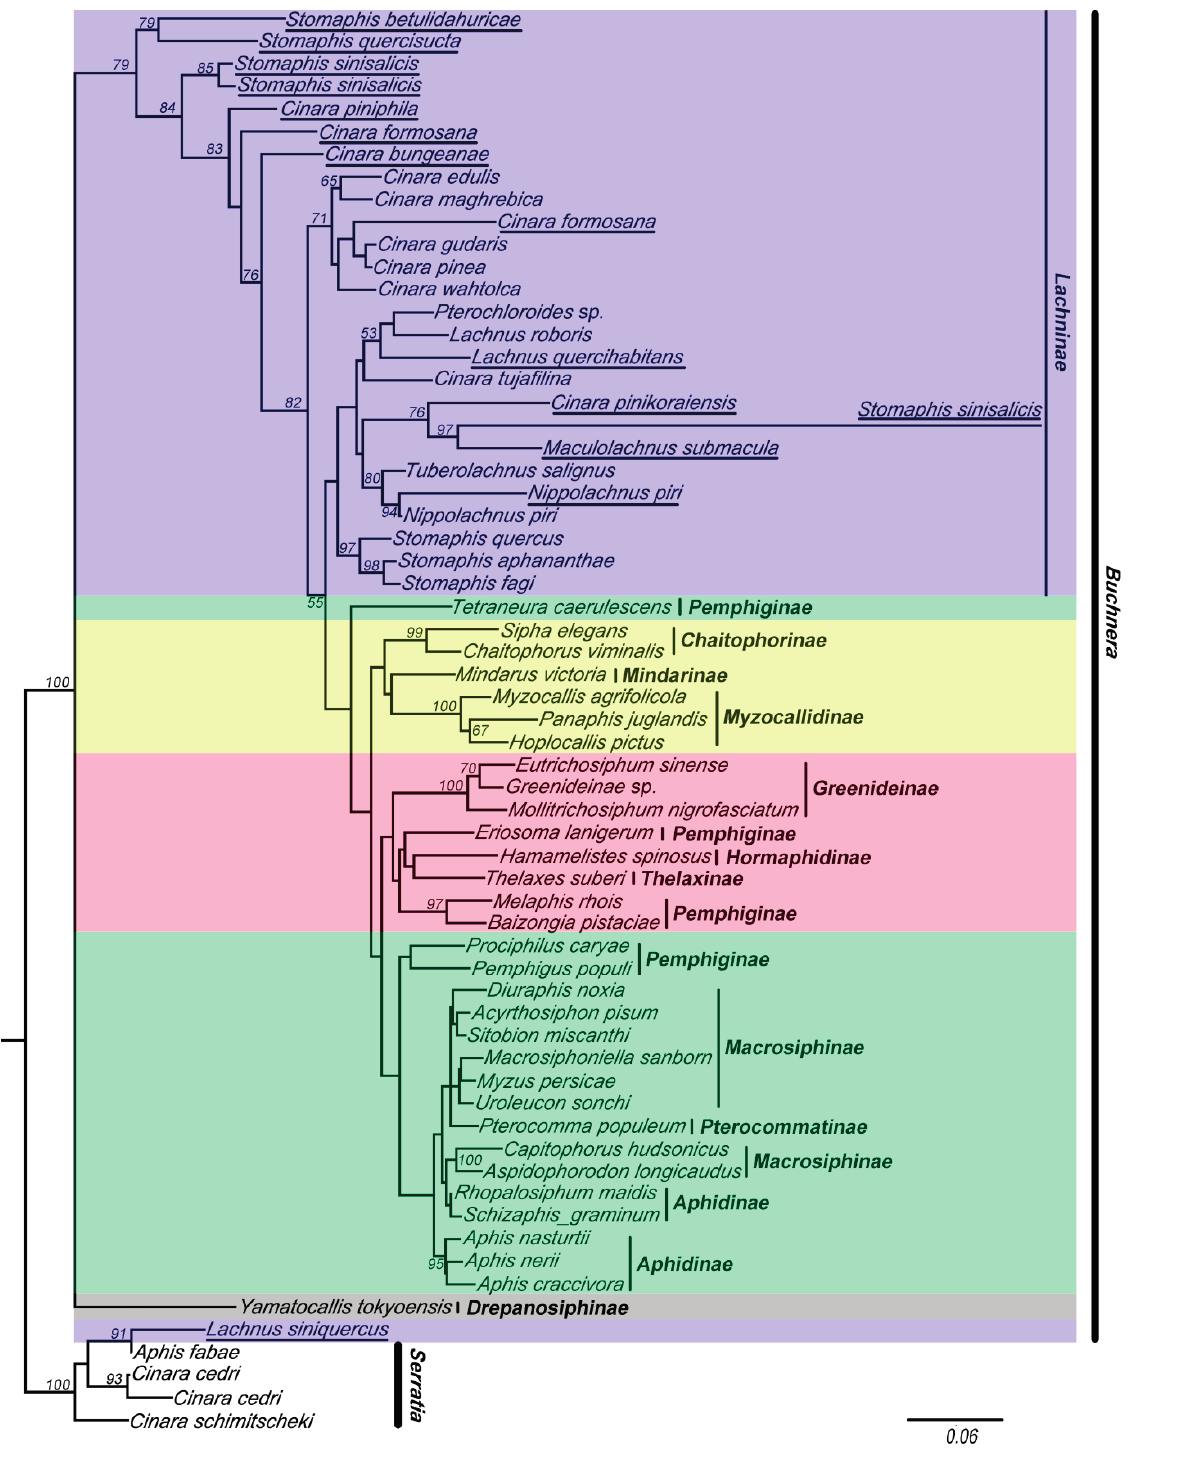
Figure 3. The maximum likelihood (ML) phylogenetic tree inferred from data-set II (with chimeric sequences, violet clade). Buchnera sequences are represented by the names of their host species. The chimeric sequences obtained from this study are underlined. The nodes are marked by their ML bootstrap values. The bar represents a 6% sequence change with regard to the likelihood distance. The underlined species are with chimeric